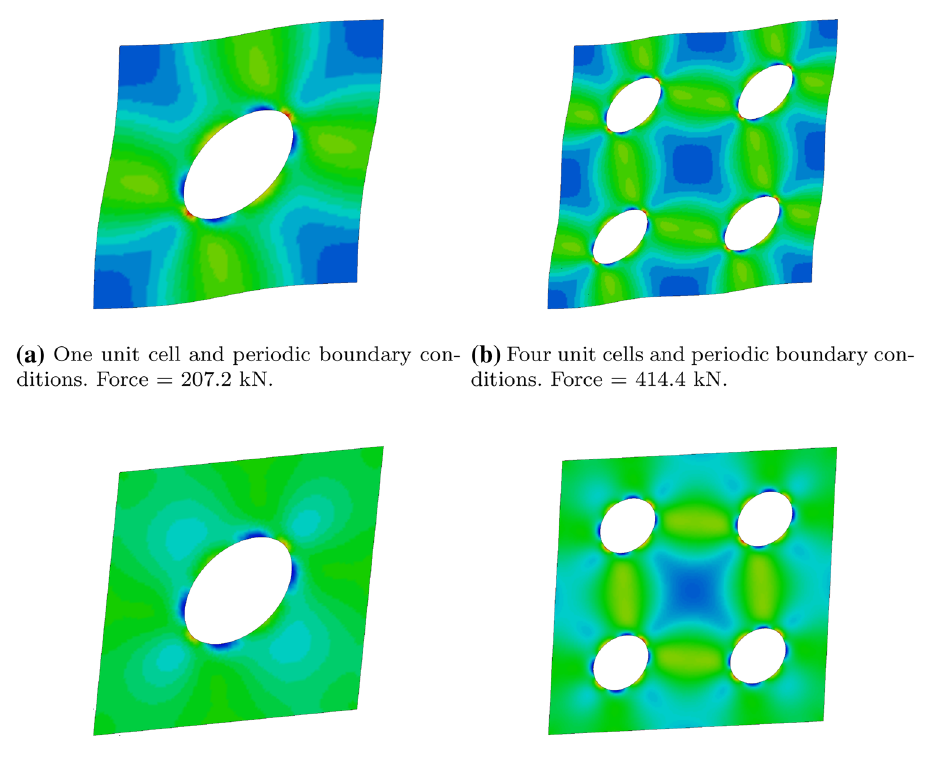
Fig. 9 In-plane shear stress is illustrated for an example where a comparison between periodic and homogeneous boundary conditions is made under in-plane shear